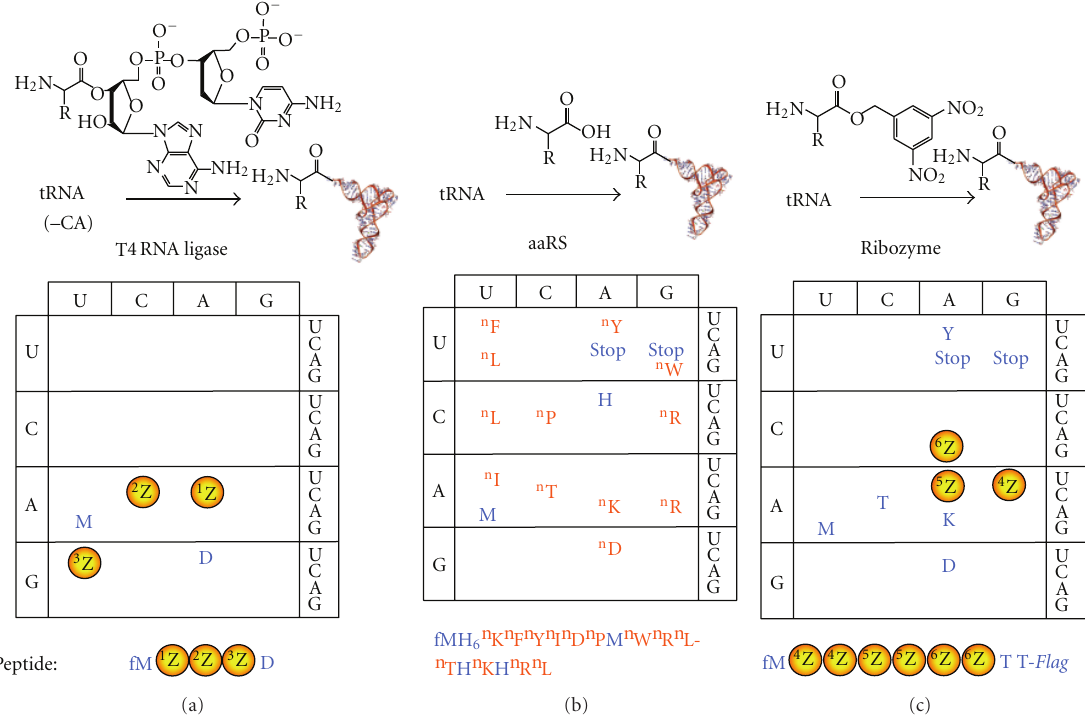
Figure 3: Comparison of the aminoacylation methods used for genetic code reprogramming. (a) Chemoenzymatic acylation method. The dinucleotide carrying the nonproteinogenic amino acid (pdCpA-aa) was enzymatically ligated to tRNA lacking 3 (cid:2) -nucleotides (pCpA). Aminoacyl-tRNAs prepared by the chemoenzymatic acylation method were added to an aaRS-free reconstituted translation system to synthesize a non-standard peptide containing three nonproteinogenic residues ( 1 Z, L-propargylglycine; 2 Z, L- O -methylserine; 3 Z, L- allylglycine). (b) aaRS tRNA-misacylation method. Aminoacyl-tRNAs carrying nonproteinogenic amino acids were enzymatically generated in a reconstituted translation system. A non-standard peptide containing 13 nonproteinogenic residues was synthesized ( N X, an analog of proteinogenic amino acid X). (c) Flexizyme-based acylation method. An activated amino acid was mixed with tRNAs and flexizyme